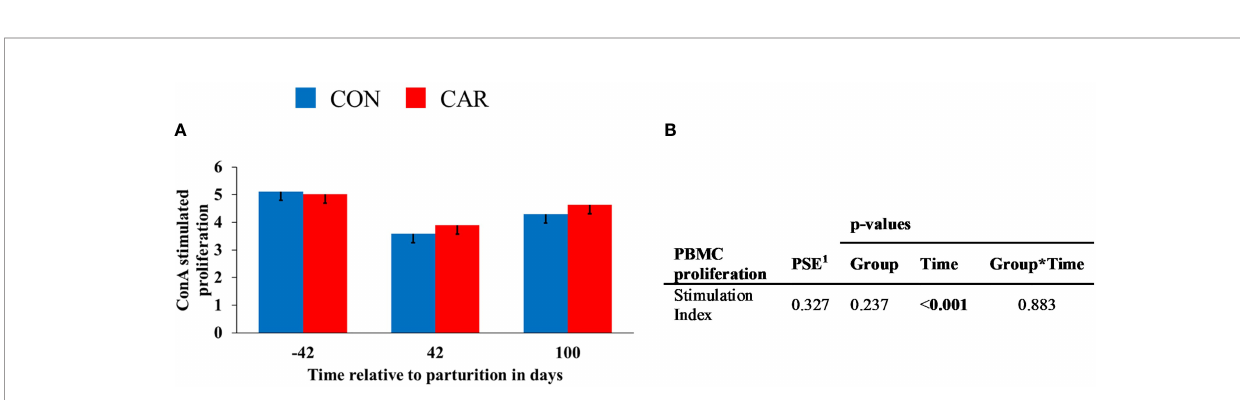
FIGURE 8 | ConA stimulated proliferation of peripheral blood mononuclear cells (PBMC) of dairy cows fed a diet supplemented with (CAR) or without (CON) L- carnitine from 6 weeks before until 15 weeks after parturition. (A) Stimulation Index (SI) is de fi ned as the ratio between the fl uorescence in Alamar Blue assay of concanavalin A-stimulated PBMC and non-stimulated PBMC. (B) Data statistics. Data are shown as least square means. 1 pooled standard error.